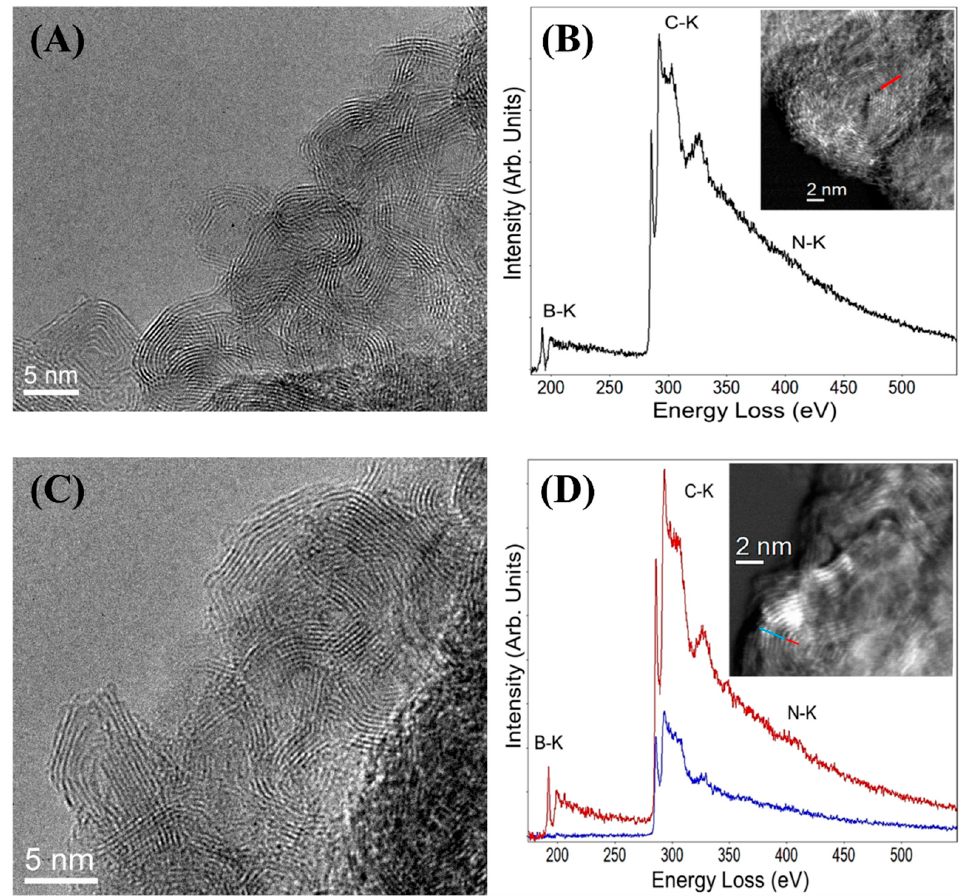
Figure 2. HRTEM images of BN-CNOs ( A ) and oxi-BN-CNOs ( C ), showing polyhedral-shaped CNOs. EELS spectra and corresponding STEM images as insets of BN-CNOs ( B ) and oxi-BN-CNOs ( D ), showing distinct B, C, and N–K edges. Blue and red lines in panel D refer to the external and internal layers, as depicted in the inset. Table 1. Elemental compositions of BN- and oxi-BN-CNOs from XPS